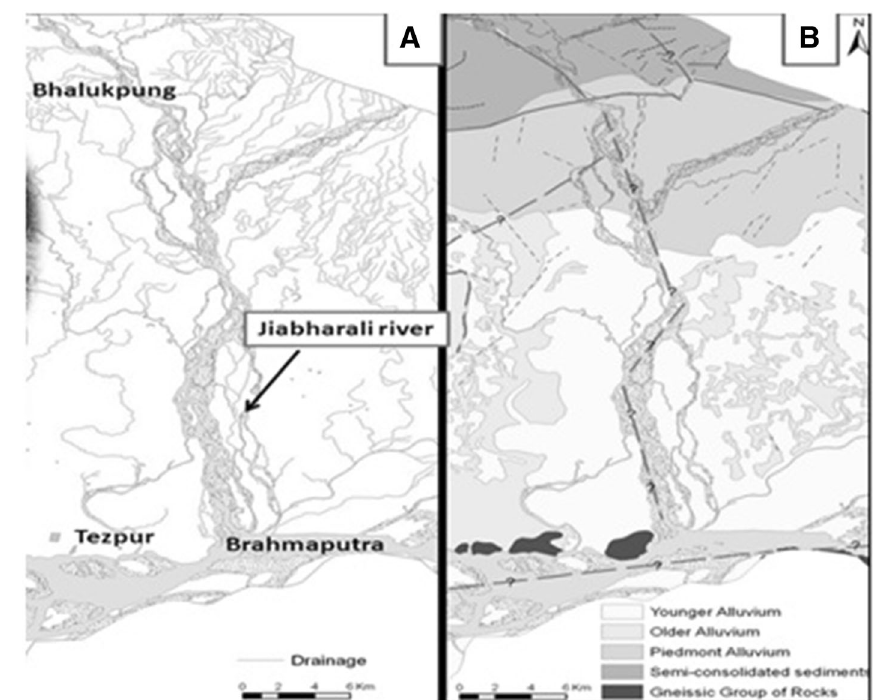
Fig. 1 Alluvial pattern of Jia